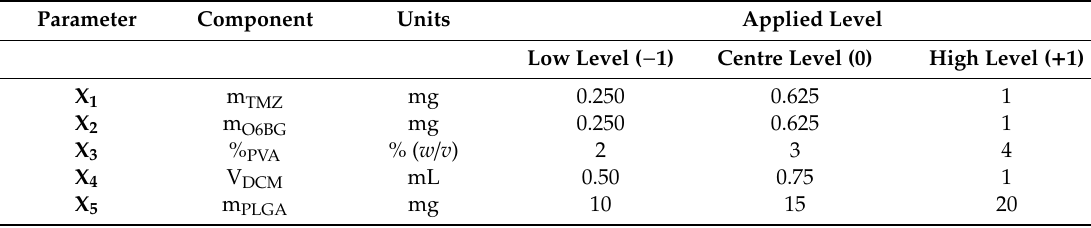
Table 1. Process and formulation parameters of the used FFD.